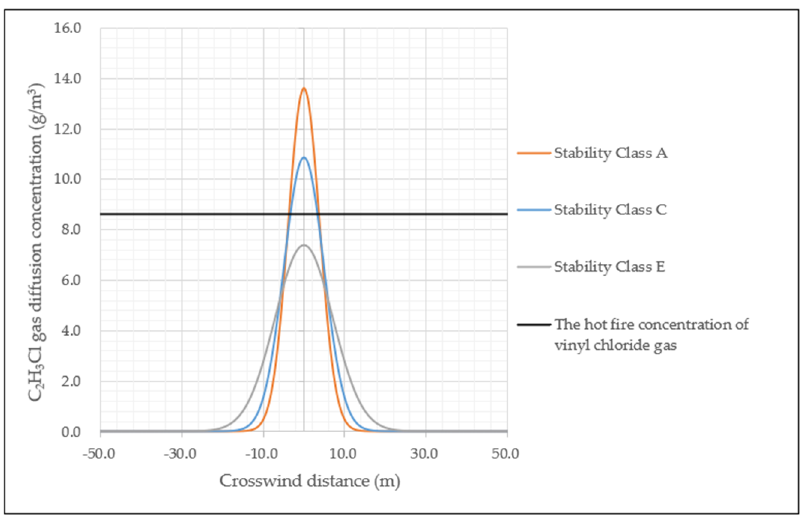
Figure 3. Diagram of concentration changes of the main wind direction of vinyl chloride at a height of 2 m from the leakage source with a stable atmosphere.